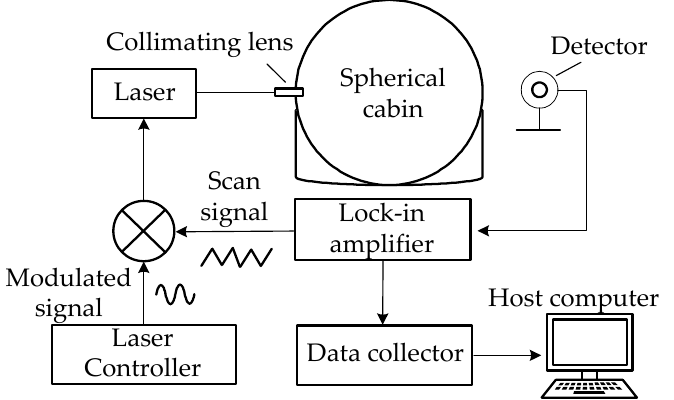
Figure 3. Methane measurement system based on TDLAS.